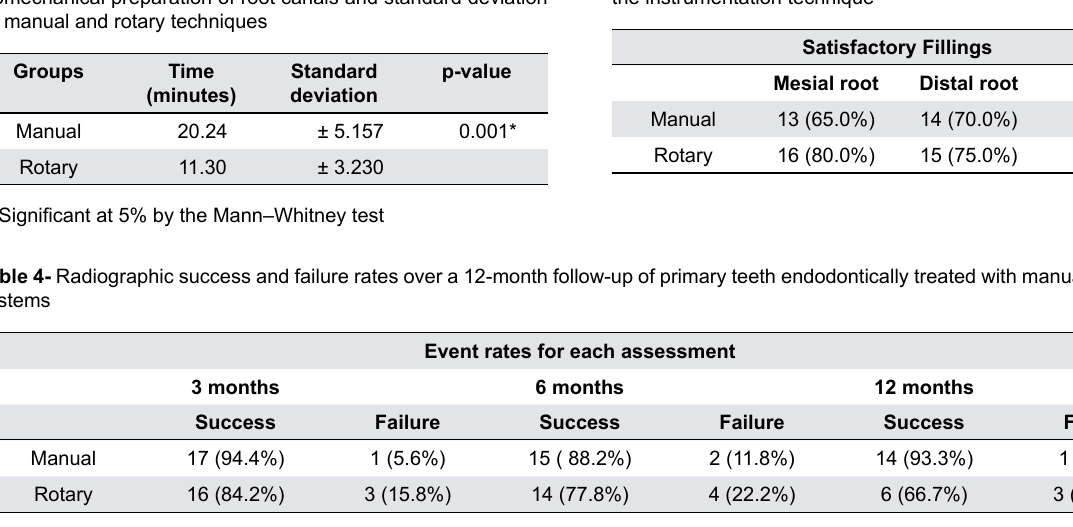
Table 5- Radiographic findings of primary teeth endodontically treated with manual and rotary systems over a 12-month follow-up